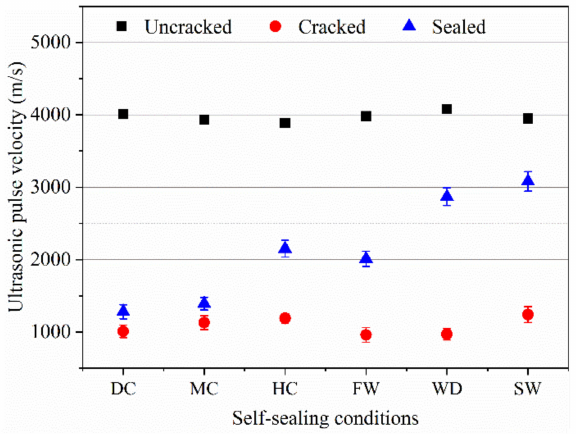
Figure 7. UPV for the samples with different states (DC: dry condition with 30% RH, MC: mild condition with 60% RH, HC: humid condition with >95% RH, FW: flowing water condition, WD: wet- dry cycles condition, SW: static water condition. The abbreviations are the same for the figures